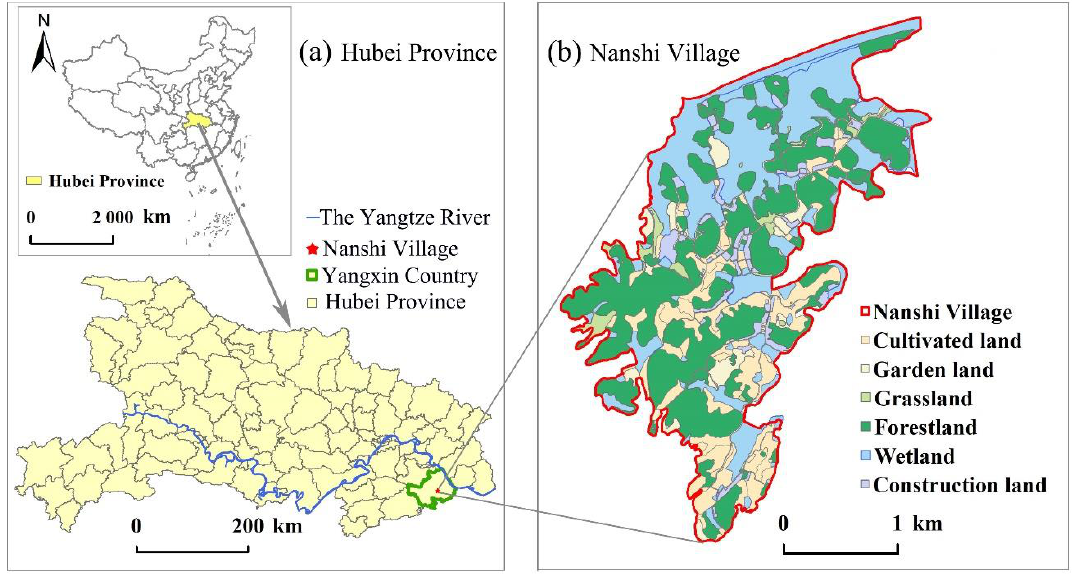
Figure 2. Spatial distribution of the study area.